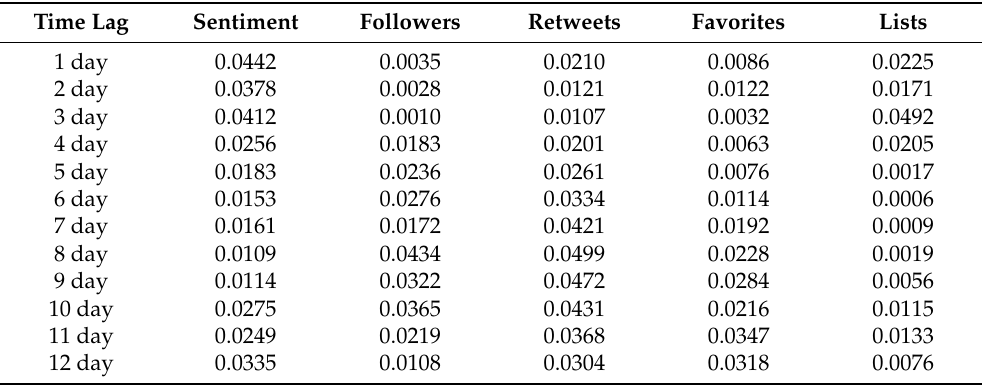
Table 8. Statistical significance ( p -values) of bivariate Granger causality correlation for Ethereum popularity based on tweet sentiment, followers, retweets, favorites, and